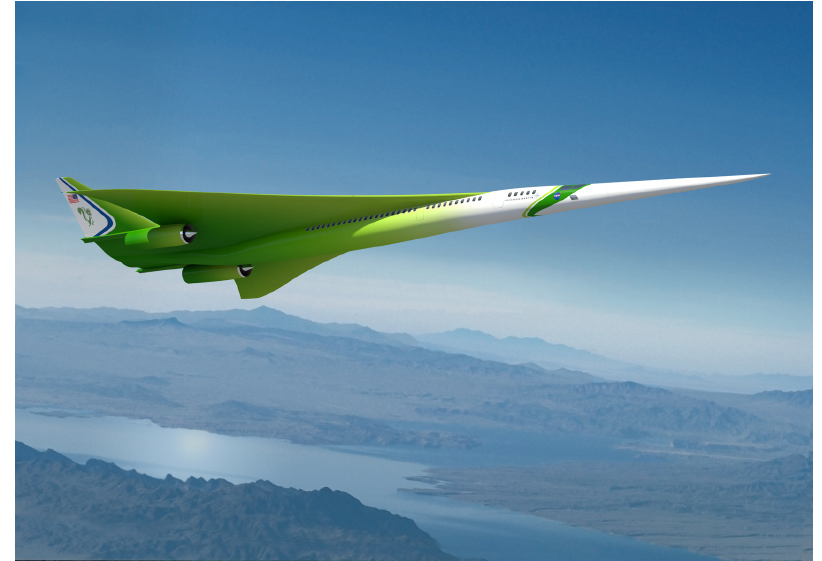
Figure 6. Artist’s concept of the Lockheed-Martin N+2